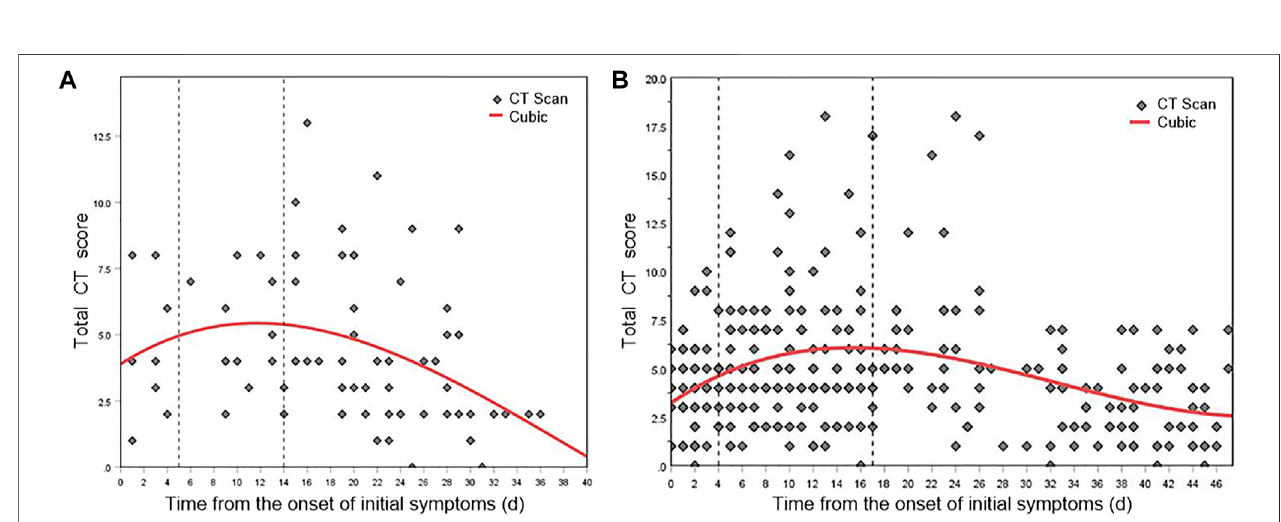
Frontiers in Molecular Biosciences |